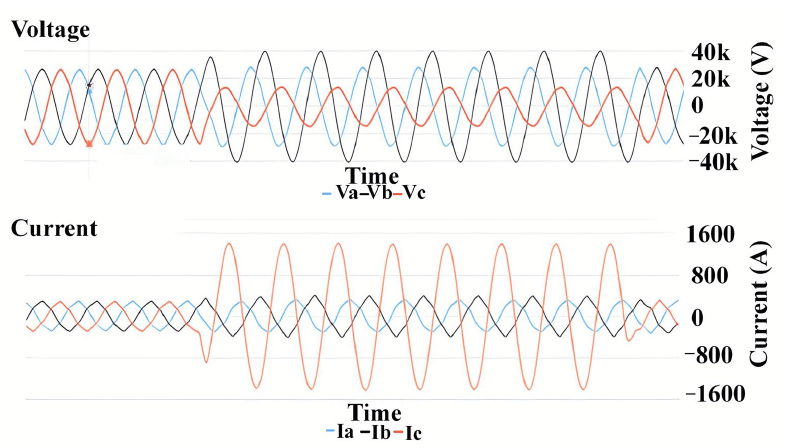
Figure A1. Current and voltage waveform recorded by PQ analyzer during the voltage sag for event 1.